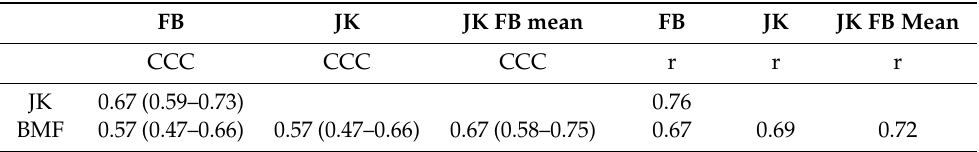
Table 4. Concordance of correlation (CCC) (95% confidence interval) having accounted for repeated measures and the Pearson’s correlation (r) for the week of 12 April 2016 (no repeated measures) for comparison with Mullins et al.